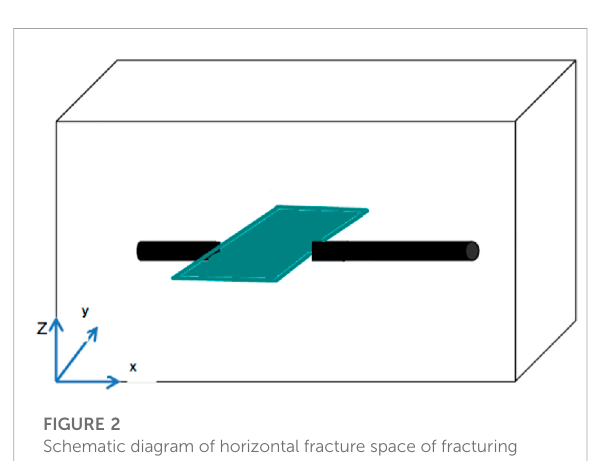
FIGURE 2 Schematic diagram of horizontal fracture space of fracturing in the horizontal well